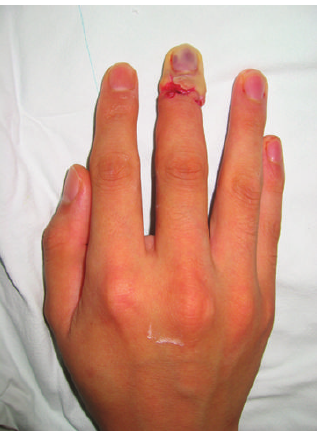
Figure 1: Replanted finger with vascular insufficiency.